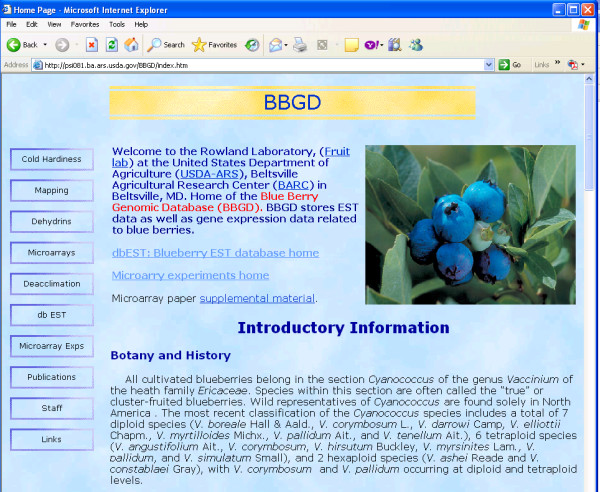
A snap shot of BBGD's main web page that shows the wealth of information that is available through the web site and the general capabilities of the database.